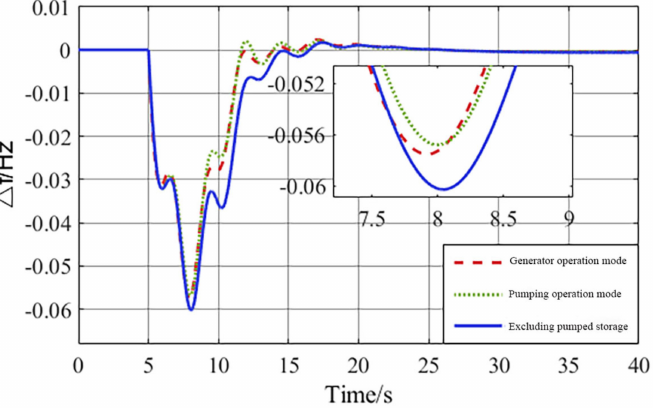
Figure 8. Frequency variation curve of a pumped storage unit containing a pumped storage unit under a step disturbance.